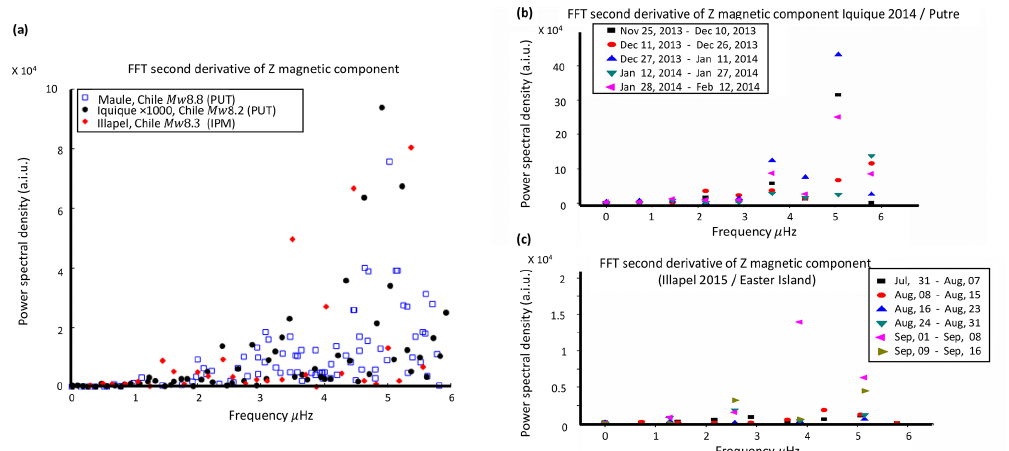
Figure 4. (a) Fast Fourier transformation (FFT) of the second derivative B z component at Putre station for different events: Maule 2010 and Iquique 2014. The rise in frequencies in the range of microhertz are compared to the FFT of the second derivative at IPM station for Illapel 2015. (b) FFT every 15d for Iquique 2015 at the Putre magnetometer. (c) FFT every 8d for Illapel 2015 at the Easter Island magnetometer.